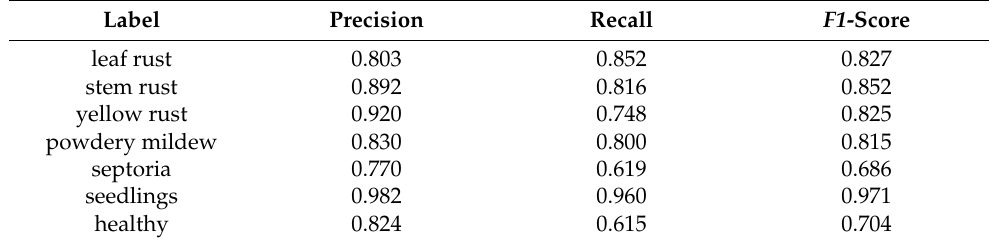
Table 7. Performance characteristics for the EfficientNet-B0_FDA neural network training